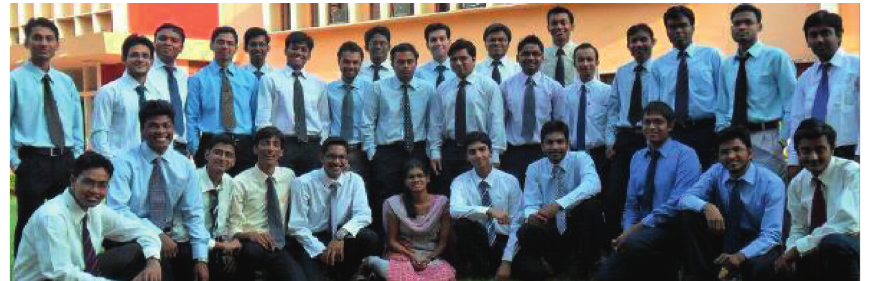
Figure 7: The original image.